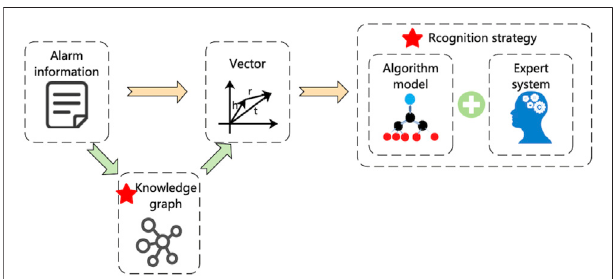
FIGURE 1 | Monitoring event recognition